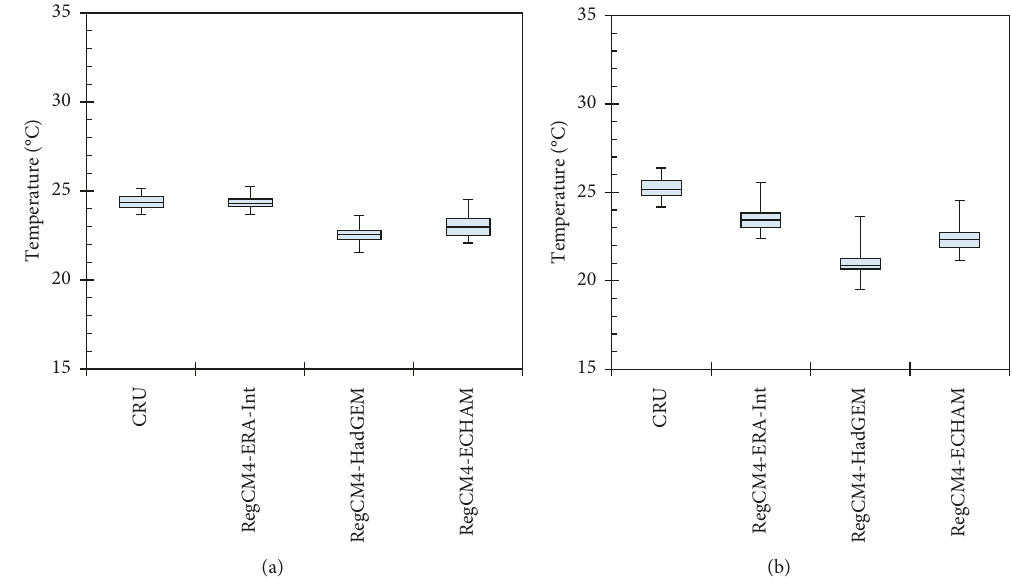
Figure 4: Box plots of RegCM4-simulated air temperature (in ° C) for each model for the past climate averaged over (a) 11 subdomains for the CORDEX-MENA/Arab domain and (b) subdomain over the Arabian Peninsula. The temperature is averaged over the period